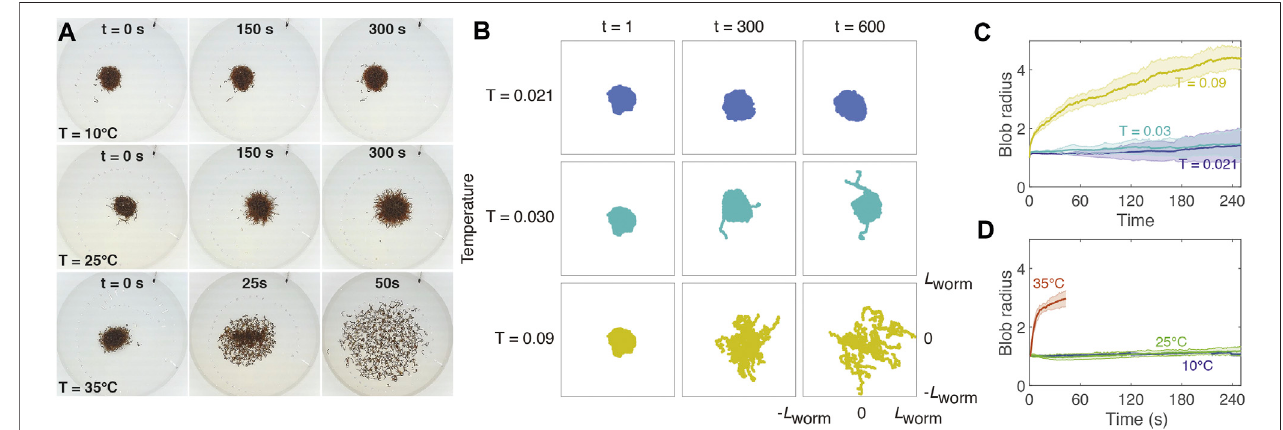
FIGURE 3 | Temperature affects cohesion of worm blobs. (A) : Snapshots of experimental blobs ( N ∼ 600) at 10, 25, and 35 ° C. Experiments at T (cid:1) 35 ° C were performedforonly1 minsince wormsbegintodieafter about2 minatthistemperature.Thediameterofthedishis20cm. (B) .Snapshotsofsimulatedblobsat different temperatures (row) and time steps (column). Each box is a square with side twice the equilibrium length of one worm ( L worm (cid:1) 41 σ ). Each blob contains 20 worms with attachmentstrength ε blob (cid:1) 12. (C) :Meanradius ± SDofsimulatedblobasafunctionoftimefordifferenttemperatures(T (cid:1) 0.021(darkblue),0.03(cyan),and 0.09 (yellow)),correspondingroughlytotheexperimentaltemperaturesused inpanel (A) . Foreach trial,the radius isnormalizedtotheinitialradius at t (cid:1) 0. (D) :Meanradius ± SDofexperimental blob ( N ∼ 600)asafunctionoftimefordifferenttemperatures(T (cid:1) 10(blue),25(green),35(red) ° C).Foreachtrial,theradius isnormalized totheinitial radius at t (cid:1)